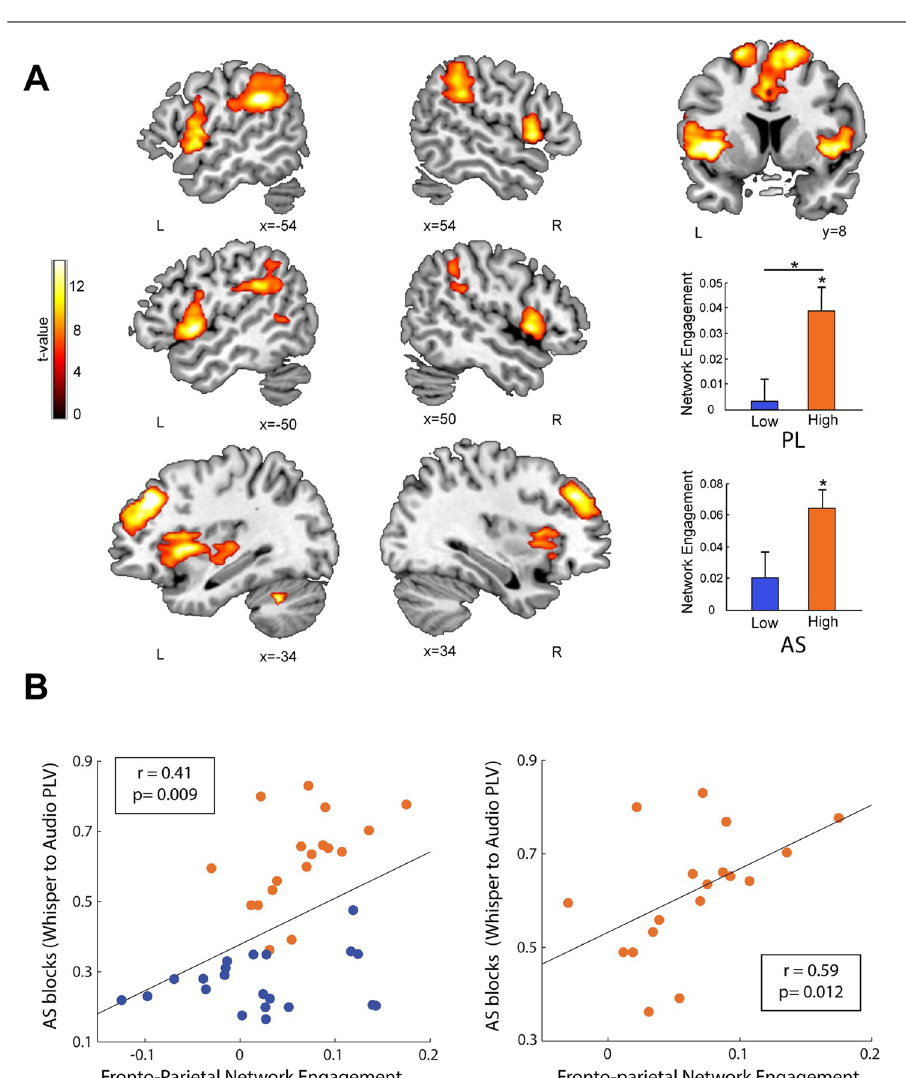
Fig 3. High synchronizers activate an additional brain network during statistical word learning. (A) In red/yellow, the frontoparietal network is shown over a canonical template, with MNI coordinates on the lower portion of each slice. Neurological convention is used. A p < 0.05 FWE-corrected threshold at the cluster level with an auxiliary p < 0.001 threshold at the voxel is used. This is the only network showing significant differences in activity between high and low synchronizers during PL (see bar plots on the lower right; � p < 0.05, FDR corrected). ( B) Scatterplot displaying participants’ PLV during AS as a function of the frontoparietal network’s engagement. Black line represents the correlation of the data. Left panel: all p AU : Pleasenotethatasperstyle ; thetermsubject = sshouldnotbeusedforhumanpatient = s : Hence ; allinstancesofsubject = shavebeenchangedtoparticipant = swhereappropriate : Pleasecheckandcorrectifnecessary : articipants. Right panel: high synchronizers. Data for Fig 3A (top bar plot) can be found in S7 Data. Data for Fig 3A (bottom bar plot) and for Fig 3B can be found in S3 Data. FDR, false discovery rate; FWE, family-wise error; MNI, Montreal Neurological Institute; PL, passive listening; PLV, phase locking